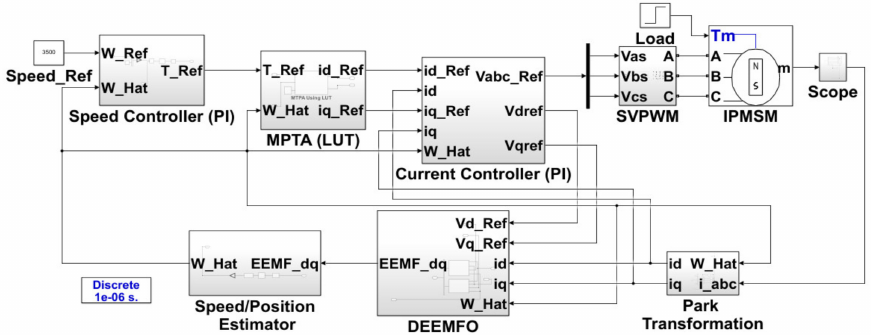
Figure 6. MATLAB/Simulink simulator for IPMSM sensorless